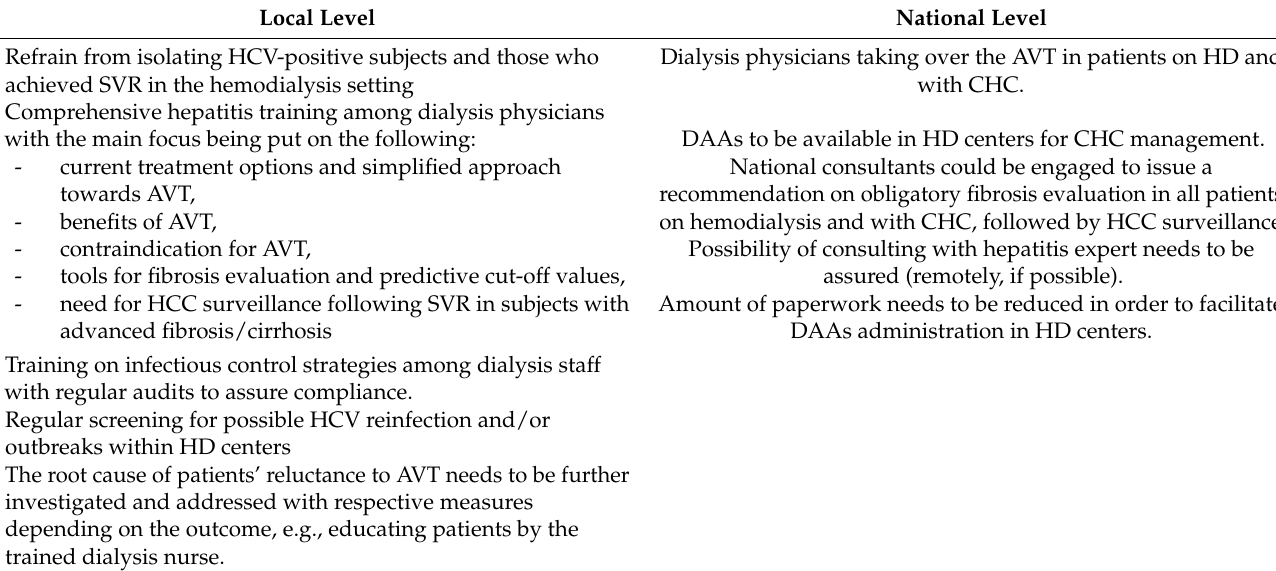
Table 5. Solutions on local and national levels to improve HCV management in hemodialysis centers in